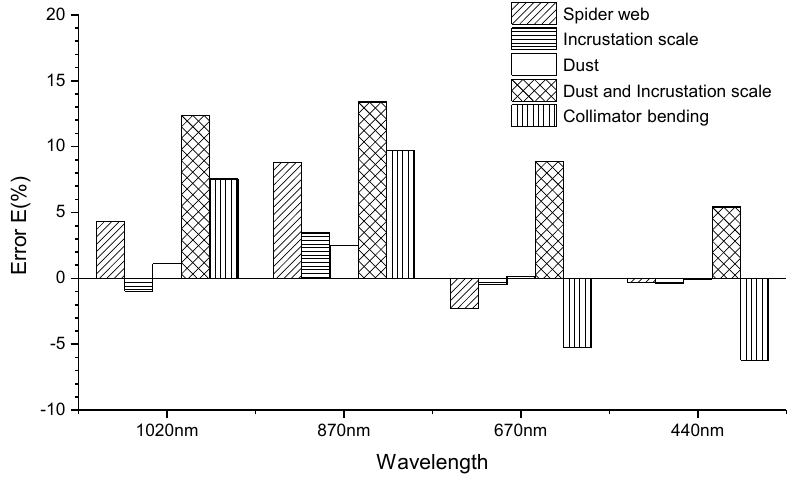
Figure 8. Actual error of AOD retrieved at 1020 nm, 870 nm, 670 nm and 440 nm between the experimental instruments and the reference instrument.